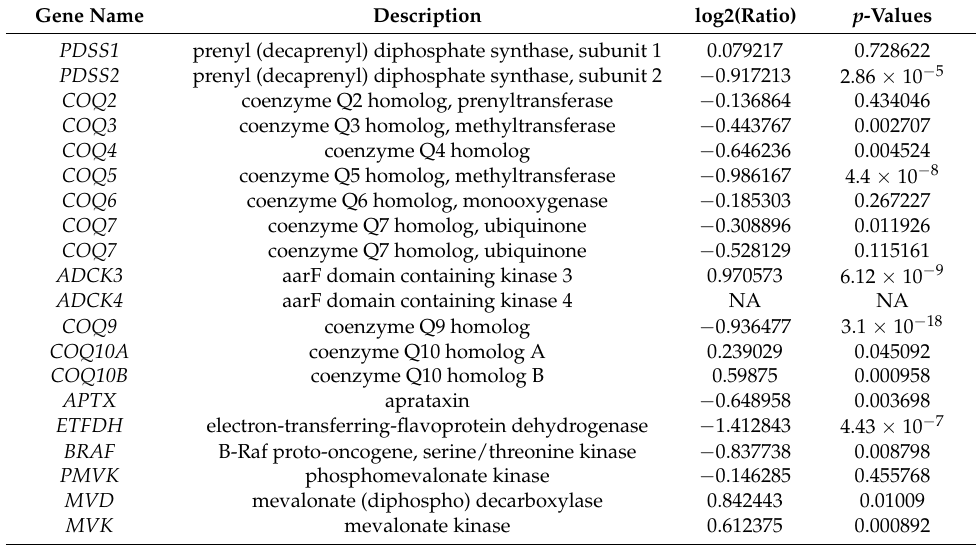
Table 1. Effect of Cr(VI) on the expression of genes involved in the CoQ10 biosynthesis pathway in L-02 hepatocytes.